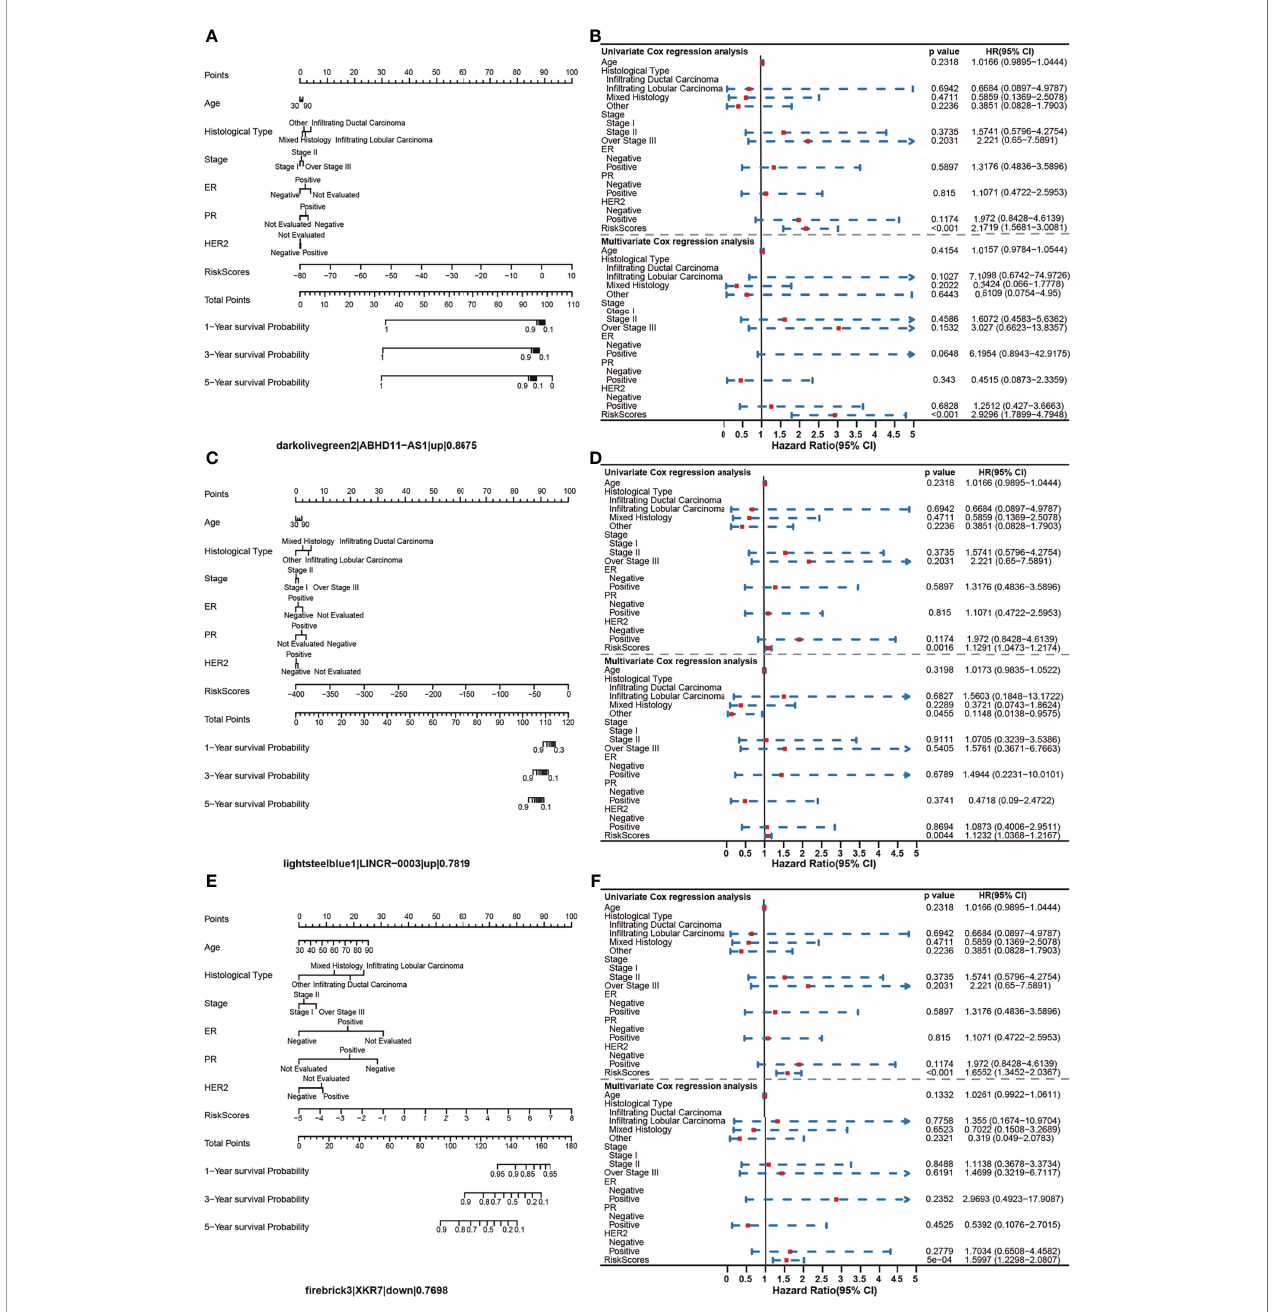
FIGURE 6 | Assessment of the prognostic risk model for BRCA. (A) Nomogram model of the darkollvereen2 module, with the leading gene being ABHD11-AS1 . (B) Univariate and multivariate regression analyses of the darkollvereen2 module. (C) Nomogram model of the lightsteelblue1 module, with the leading gene being LINCR-0003 . (D) Univariate and multivariate regression analyses of the lightsteelblue1 module. (E) Nomogram model of the fi rebrick3 module, with the leading gene being XKR7 . (F) Univariate and multivariate regression analyses of the fi rebrick3